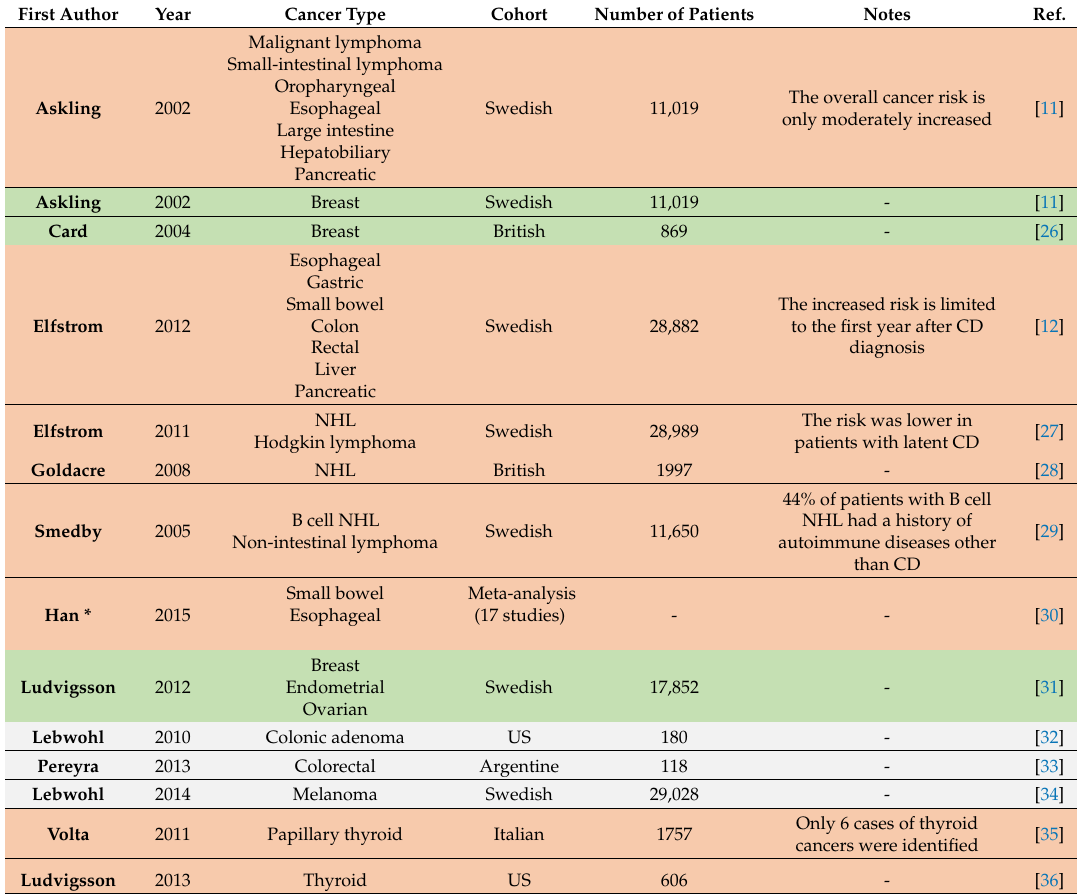
Table 2. Most relevant studies examining cancer risk in CD